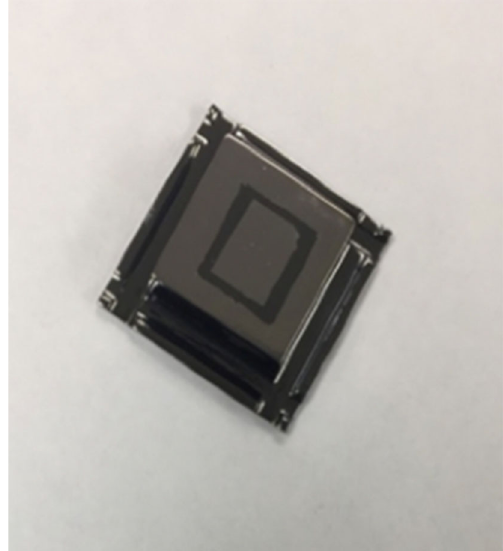
Fig. 3 Hopping transition between two localized states i and j with energies of ε i and ε j , respectively. The solid and dashed lines depict the carrier wavefunctions at sites i and j , respectively; α is the localization length; R HOP is the hopping distance; W HOP is the hopping energy